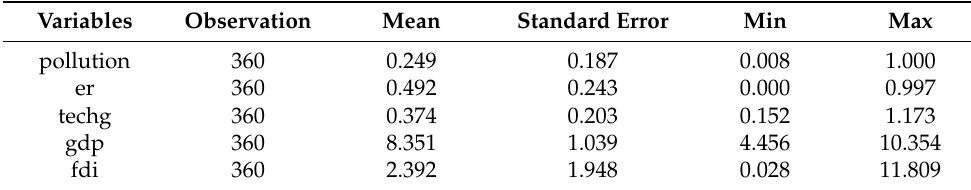
Table 2. Descriptive statistics.